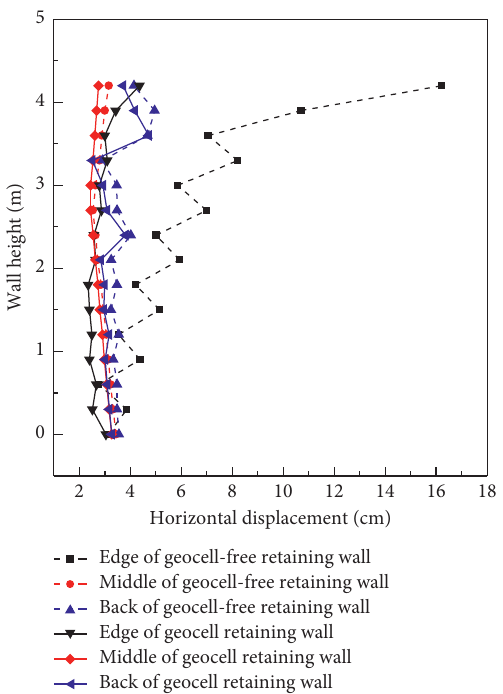
9: Vertical displacement of the retaining